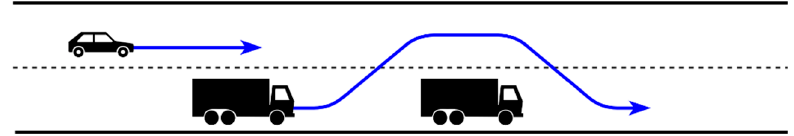
Figure 4. A cooperative truck-overtaking maneuver with the truck in front cooperating to reduce the overtaking time.